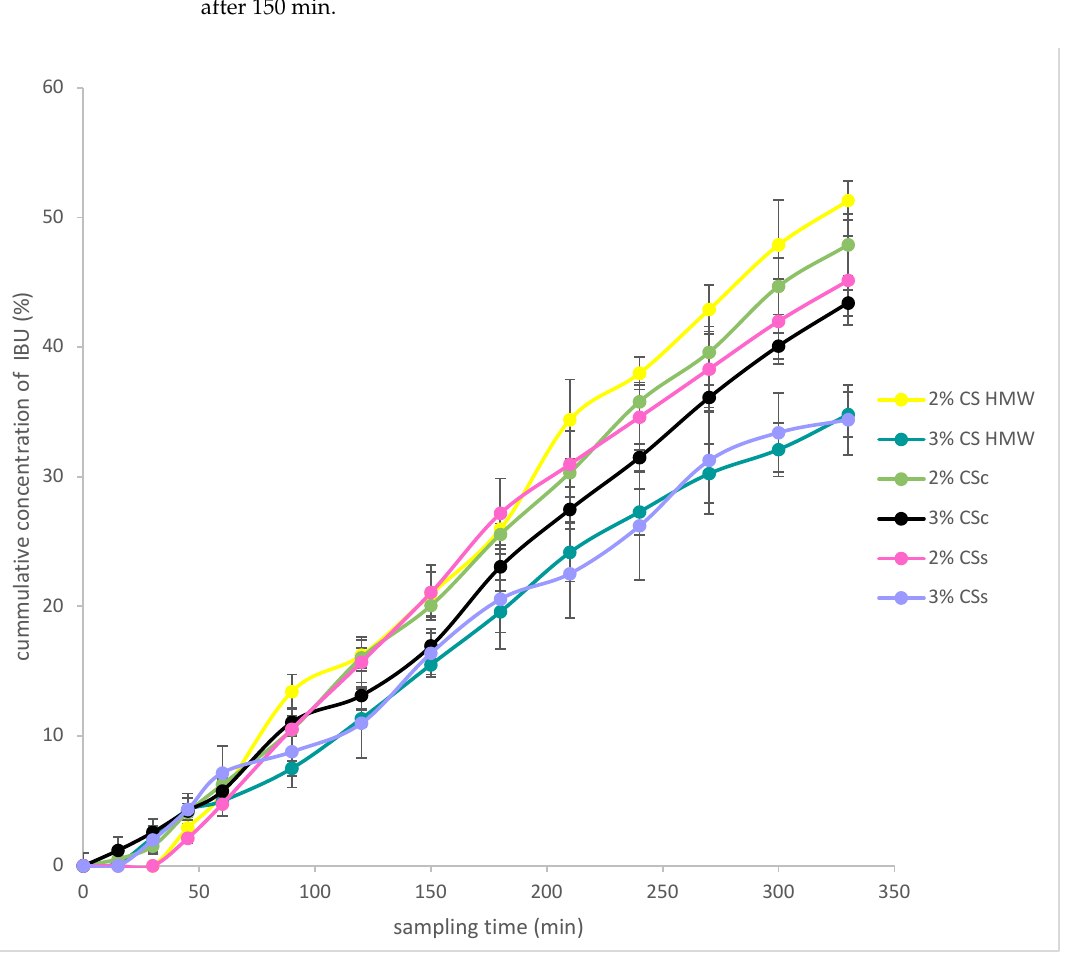
Figure A4. The cumulative amount of ibuprofen released from chosen chitosan hydrogels with time.